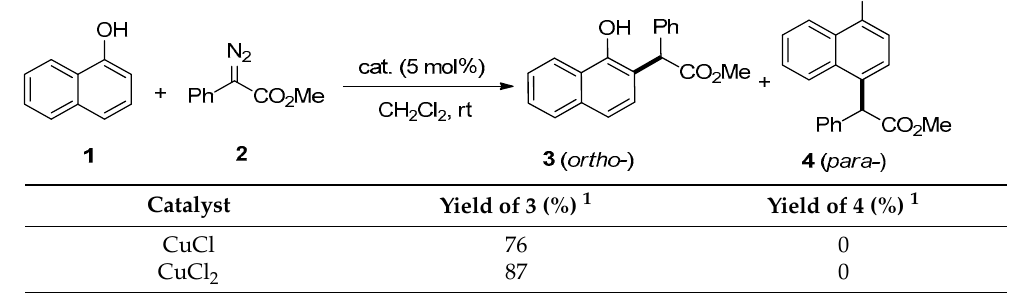
Table 1. Copper-catalyzed C(sp 2 )-H bond functionalization of naphthols with α -diazoesters [63].